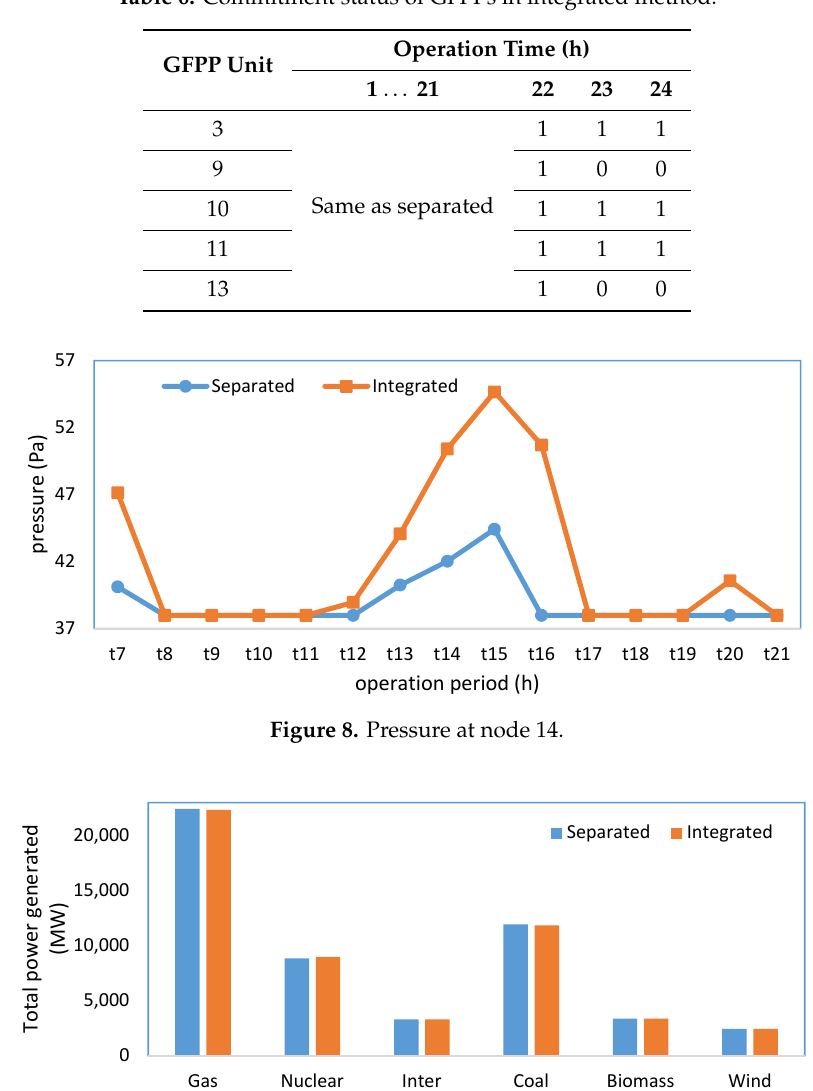
Table 6. Commitment status of GFPPs in integrated method. Figure 9. Comparison of total generated power of di ff erent types of power plants in 24 h between integrated and separated Figure 9. Comparison of total generated power of different types of power plants in 24 h between integrated and separated methods.